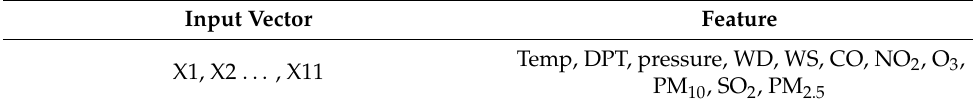
Table 1. Correspondence of characteristic